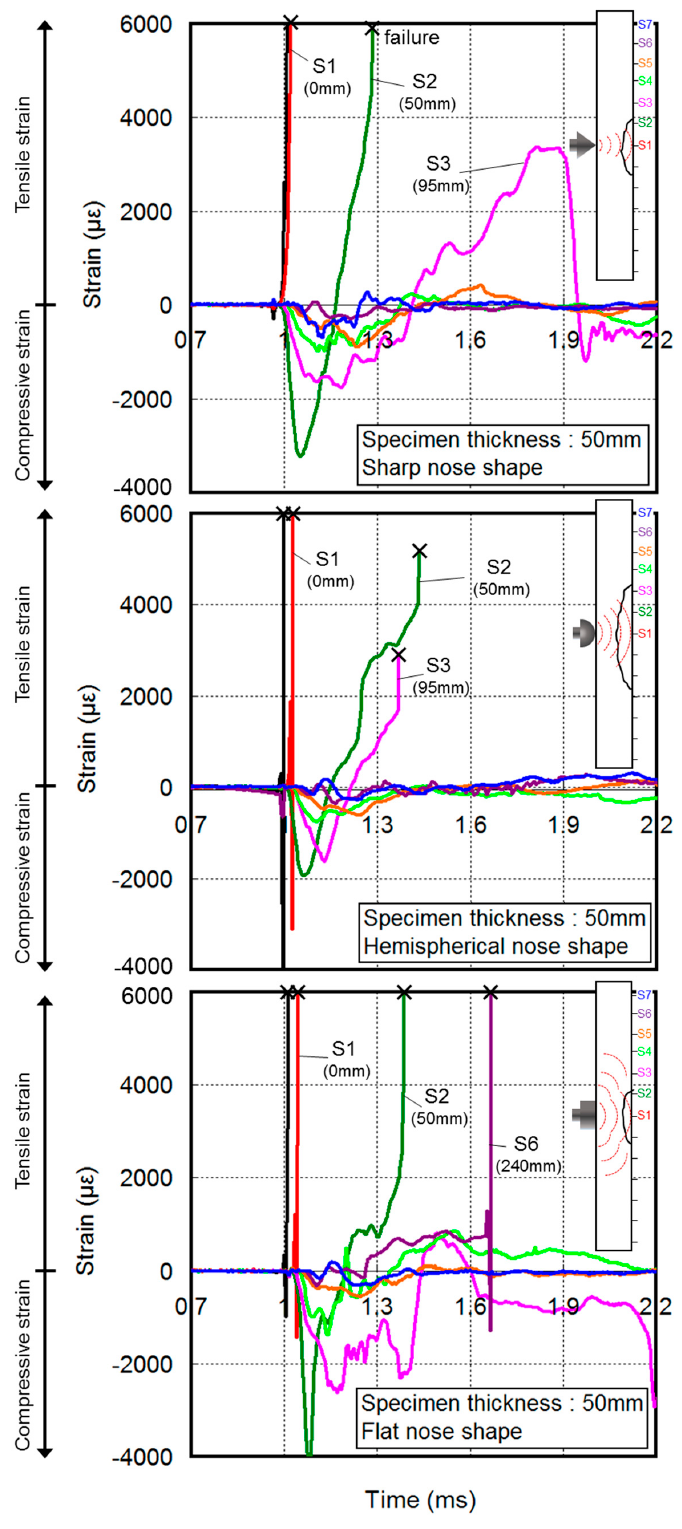
Figure 13. Rear-face strain curve of NC.